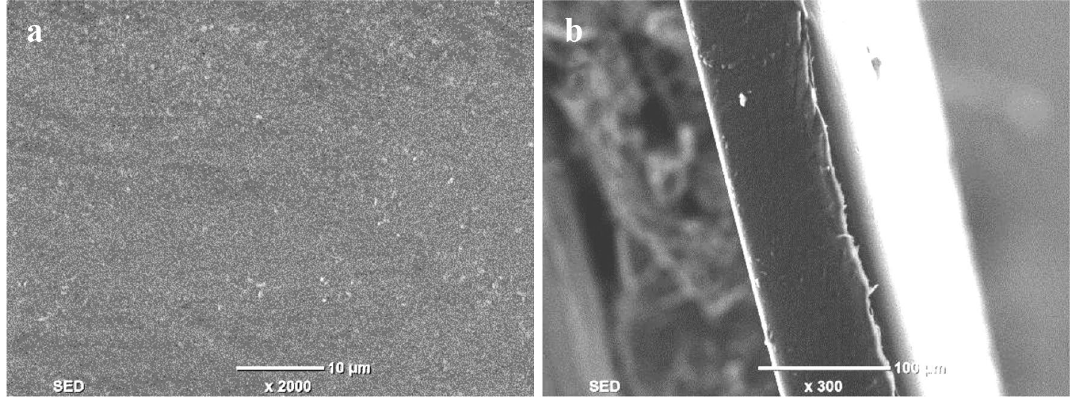
Figure 9. SEM images (floor plan ( a ) and cross section ( b )) of the membrane prepared by casting solution with 5% MCC